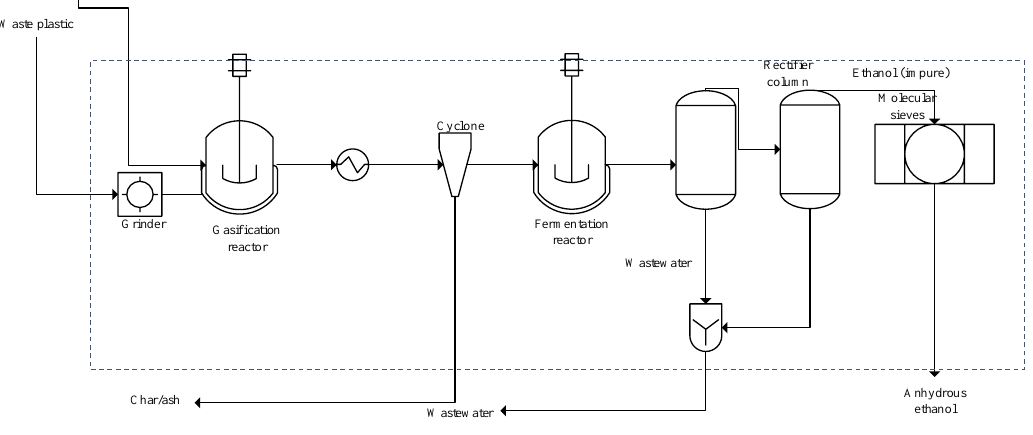
Figure 1. Waste plastic conversion to the liquid fuel of ethanol (control volume indicated with dashed lines).